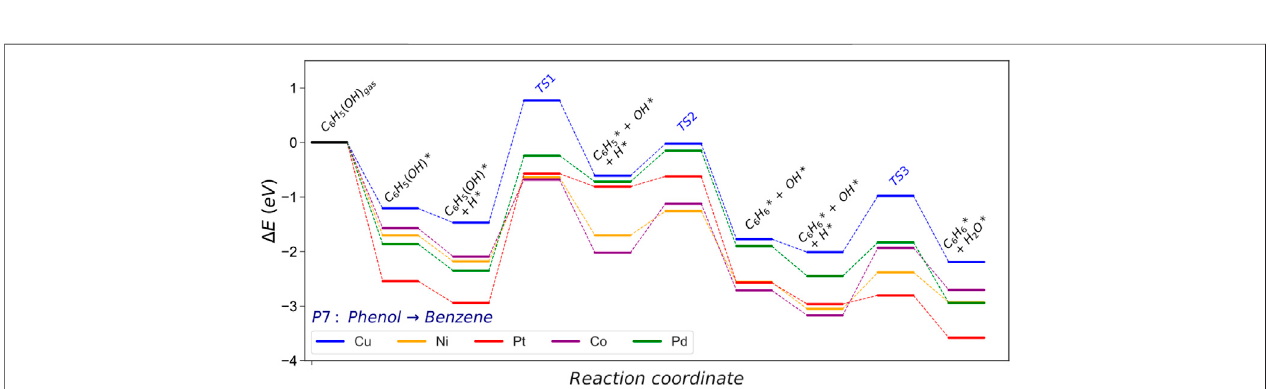
FIGURE 6 | Energy pro fi le of the hydrogenolysis (HGL) pathway converting phenol into benzene and water. The asterisk (*) represents adsorbed surface species; molecular functional groups are denoted in parenthesis.